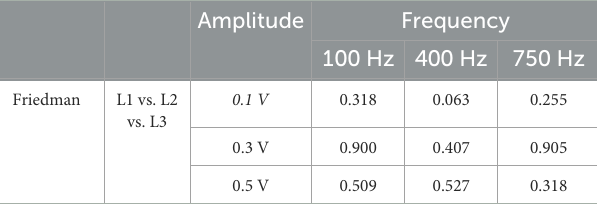
TABLE 4 The p -values of the Friedman for JND f comparing the three different physiological sites L1, L2, and L3 at all frequencies and amplitudes is